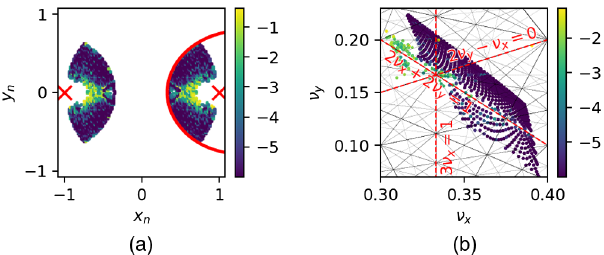
FIG. 25. Analysis of the IOTA toy-model with ν ¼ 0 . 28 and δμ ¼ 0 . 01 . The color map indicates Δ . (a) Initial conditions FMA of those particles whose time series data y has a dc frequency n component larger than the dominant nonzero frequency compo- nent. (b) Tune footprint of all particles starting from region I, shown together with a few strong resonance lines (red dashed). Here ν and ν are the horizontal and vertical fractional x y